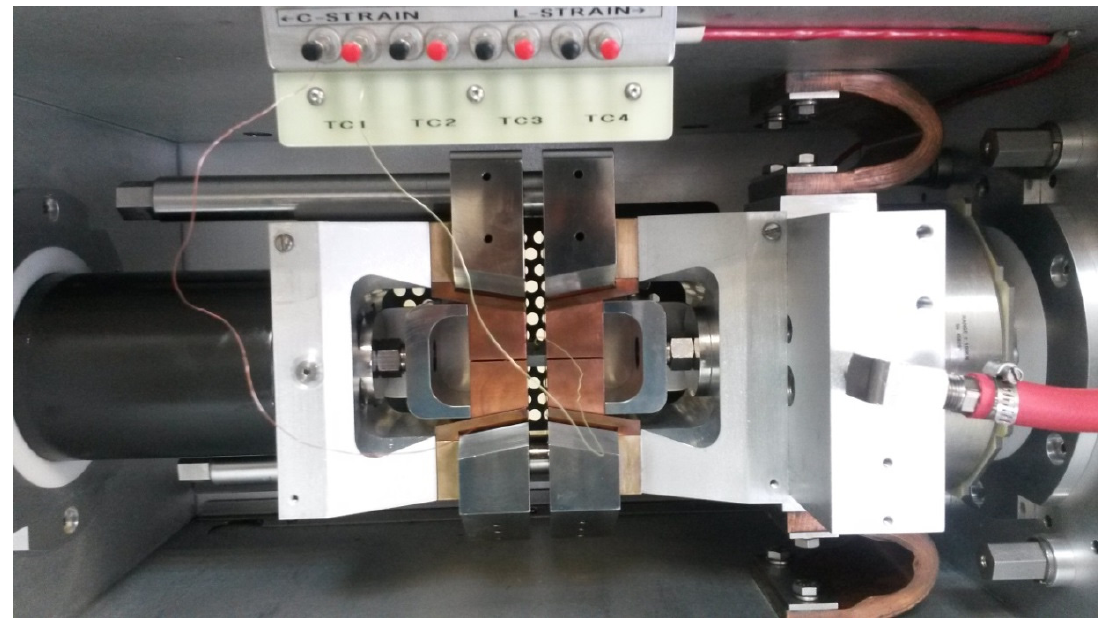
Figure 2. Specimen (in the center of the image) attached to the Gleeble ® 3800 equipment. The thermal cycle simulation of double pass welding consisted of the following steps. For the first welding pass simulation, the middle region of the test specimen was heated to 1350 ◦ C with a heat rate of 450 ◦ C/s, was maintained at this temperature for 0.35 s, was cooled down to 800 ◦ C in 20 s with a cooling rate of 27.5 ◦ C/s, and then to 200 ◦ C in t 8/5 = 160 s with a cooling rate of 3.75 ◦ C/s. The second pass simulation involved heating from 200 ◦ C to a peak temperature of 800 ◦ C with a heat rate of 266 ◦ C/s, maintaining the specimen at this temperature for 0.35 s, and then cooling it to 200 ◦ C in t 8/5 = 160 s with a cooling rate of 3.75 ◦ C/s followed by air free cooling, as shown in Figure 3.